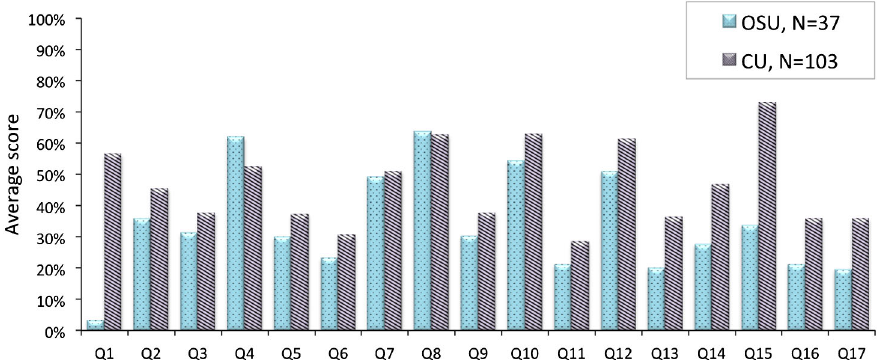
FIG. 3. Mean values for each question on the CUE post-test for OSU ( N ¼ 37 , blue dotted pattern) and for CU ( N ¼ 103 , purple hatched pattern)